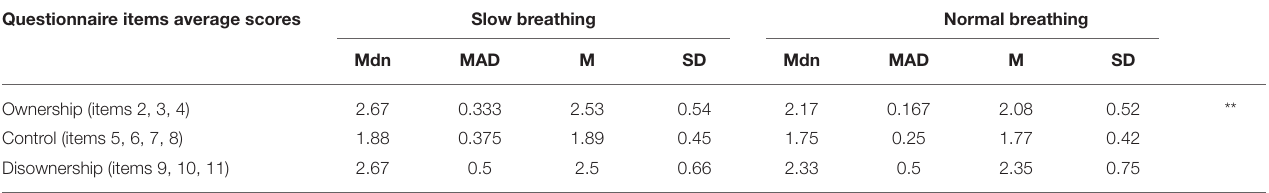
TABLE 2 | Average scores of items on ownership, control, disownership (median, Mdn; median absolute deviation, MAD; mean, M; standard deviation, SD). Questionnaire items average scores